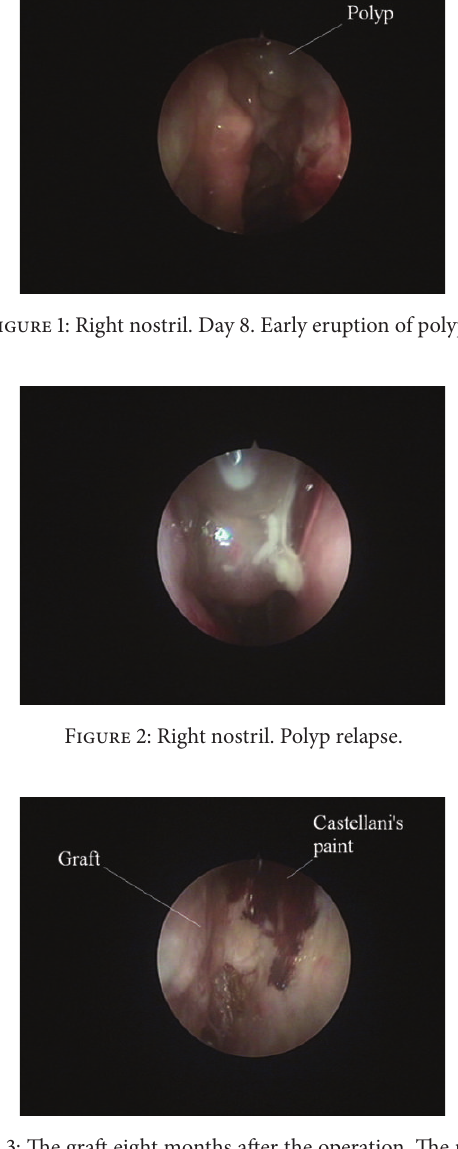
Figure 3: The graft eight months after the operation. The nostril is free of polyps and no infected debris is observed.